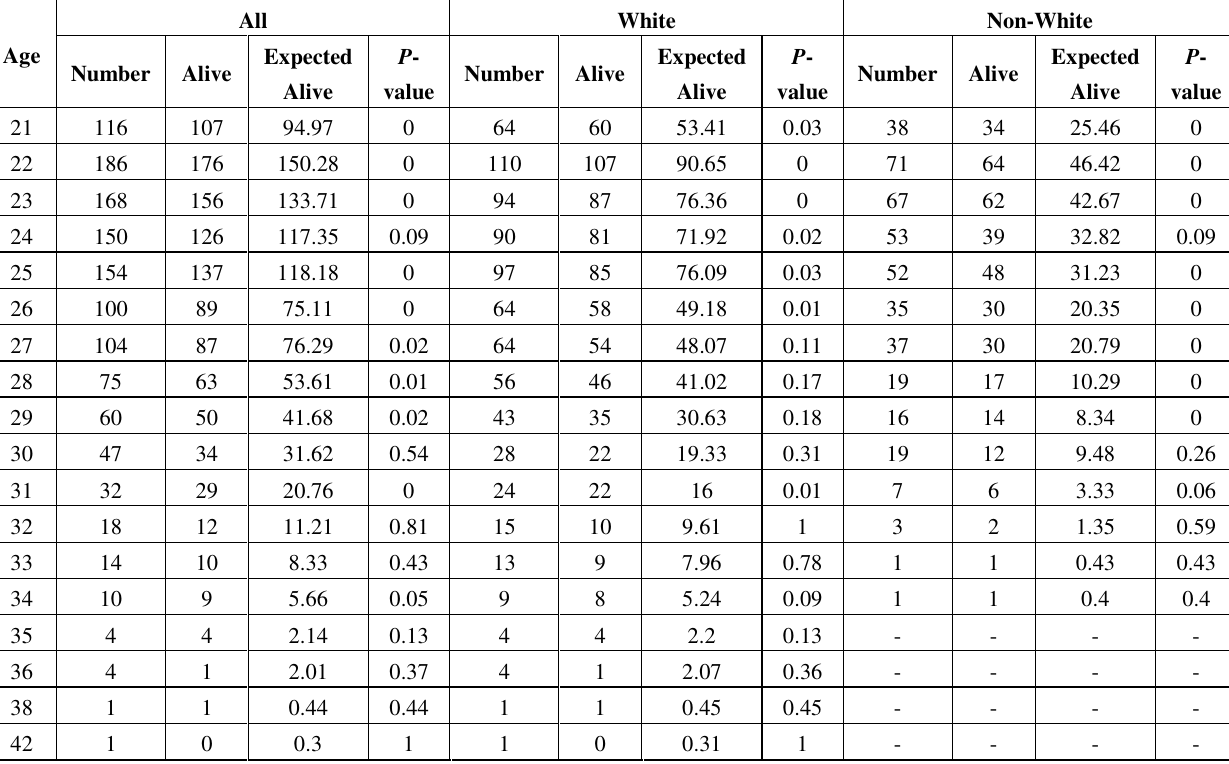
Table 2. Actual Survival and Expected Survival (1970 Season).